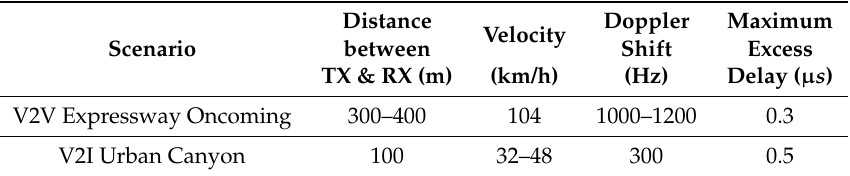
Table 2. Channel model for